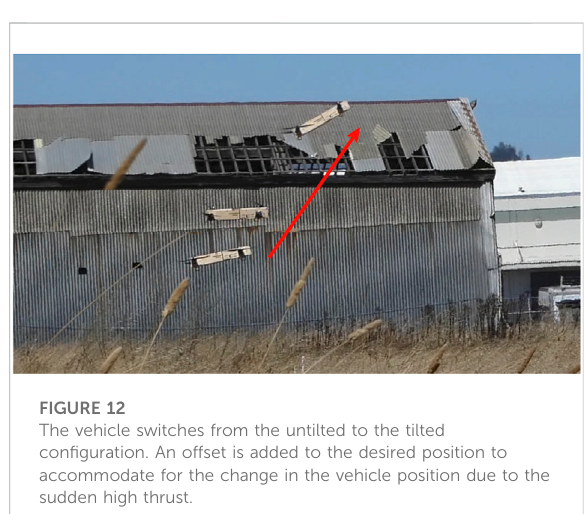
FIGURE 12 The vehicle switches from the untilted to the tilted con fi guration. An offset is added to the desired position to accommodate for the change in the vehicle position due to the sudden high